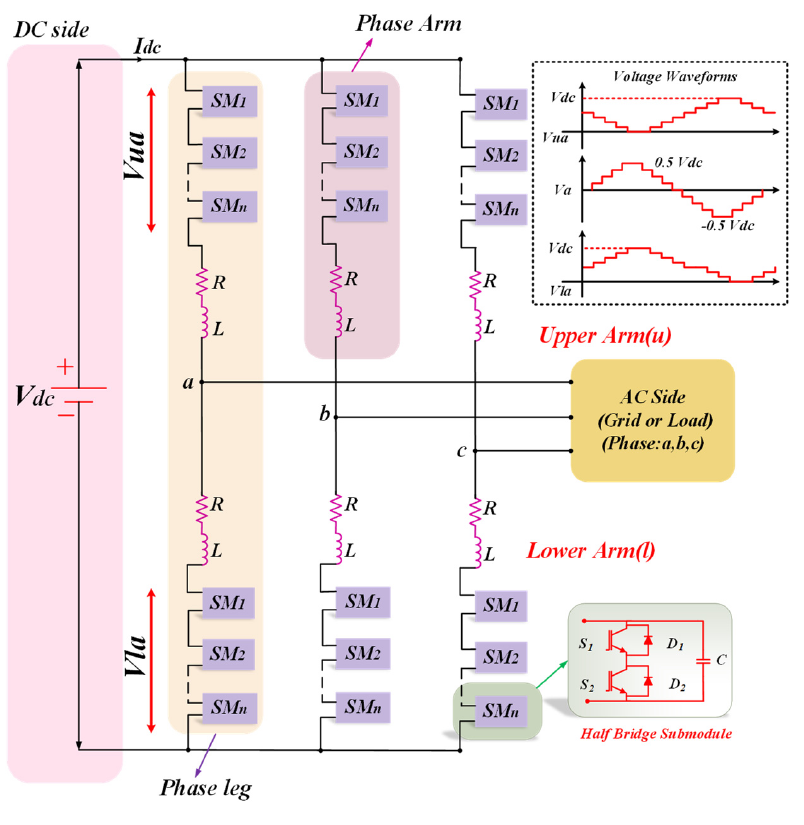
Figure 4. Three-phase MMC structure.